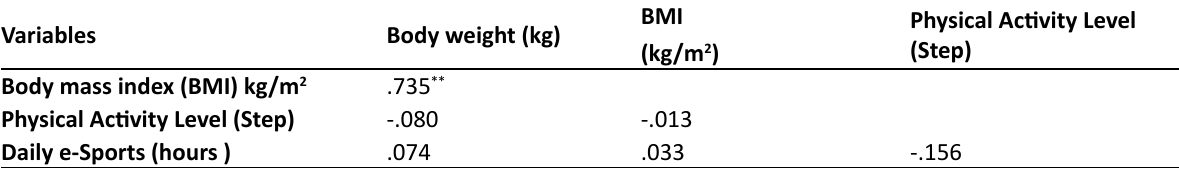
Table 3. Correlation results between participants’ research variables